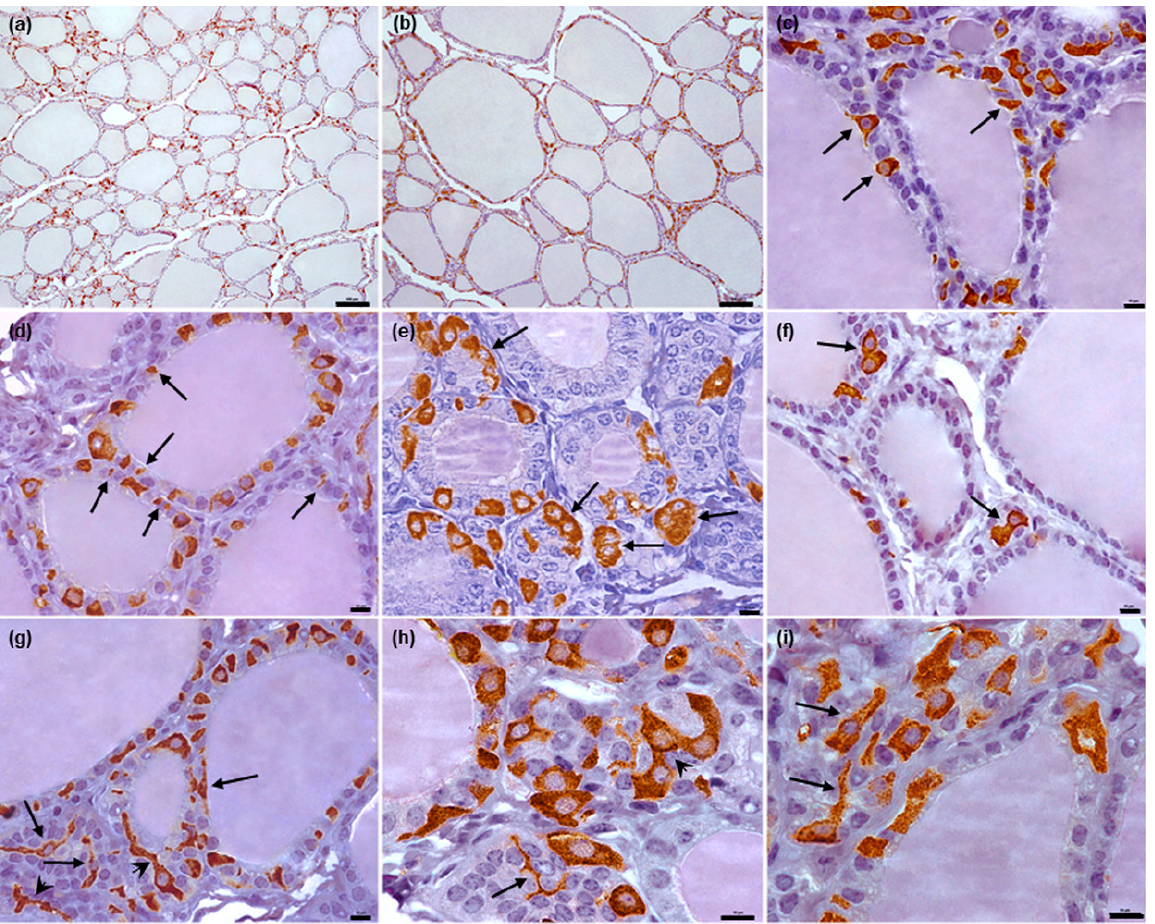
Figure 4. Representative images of bovine C thyrocytes arrangement and morphology. ( a , b ): Typical distribution of C thyrocytes in thyroid parenchyma. ( c ): Single C thyrocytes reach the apical surface of T thyrocytes (arrows). ( d – f ): Typical arrangement of C thyrocytes in thyroid follicles: cells located separately, cross-sections thorough cytoplasmic processes are visible (( d ), arrows) or in small groups (( e – f ), arrows). ( g – i ): Typical morphology of C thyrocytes in cattle, some cells possess long cytoplasmic processes (arrows) and contact with other C thyrocytes via these protrusions (arrowheads). Immunoperoxidase staining with anti-calcitonin antibody, scale bars: ( a , b ) = 100 µm, ( c – i ) = 10 µm.